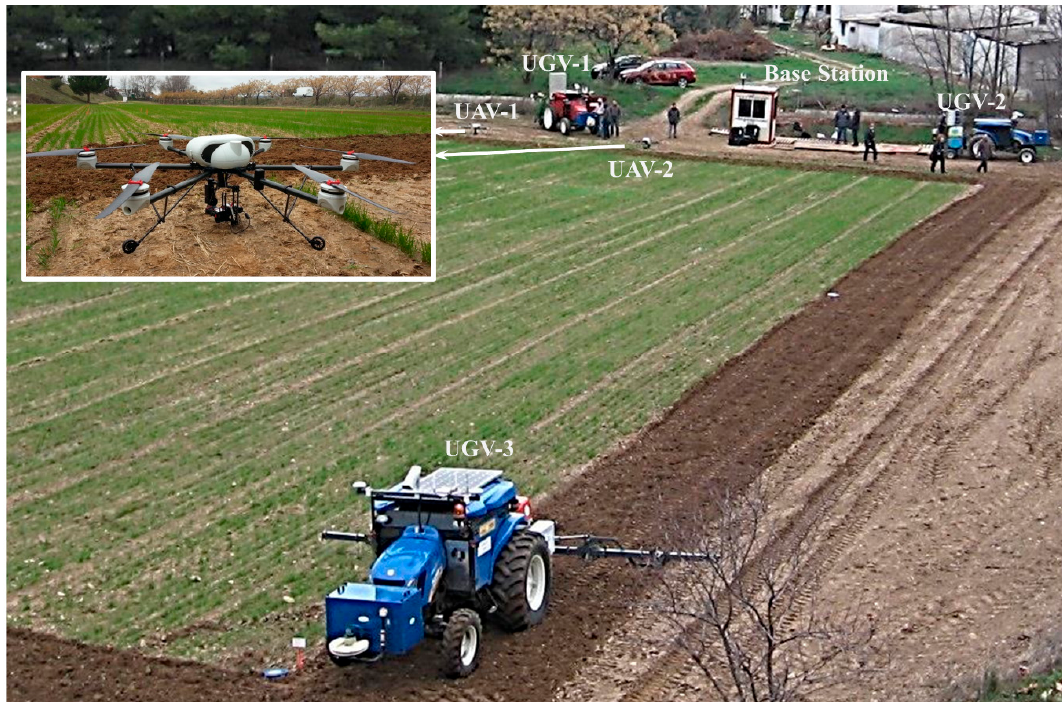
Figure 11. A fleet of robots (the RHEA fleet).